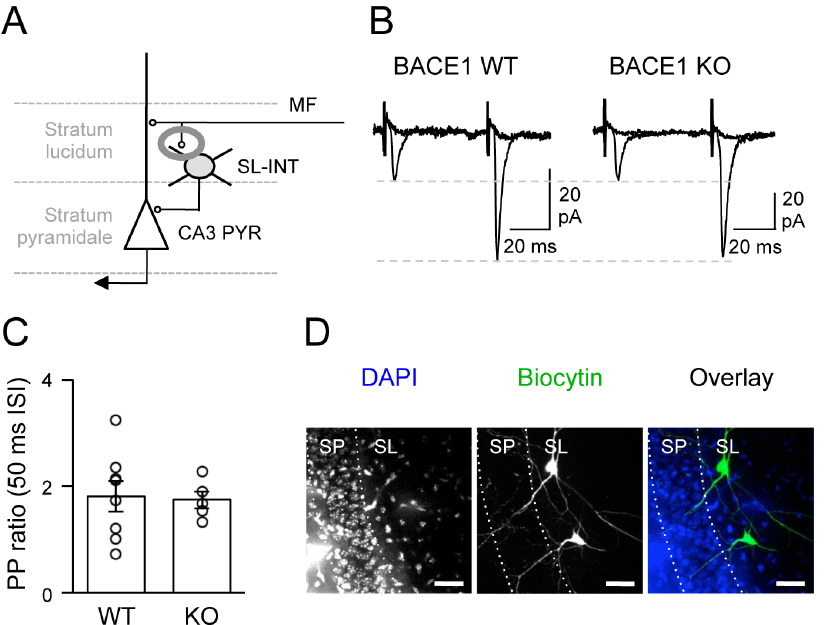
Figure 3. Normal synaptic function of MF inputs onto SL-INTs of BACE1 KOs. (A) A diagram highlighting the synapses of MF terminals onto inhibitory SL-INTs. (B) Representative evoked EPSC traces from SL-INTs following paired-pulse stimulation at 50 msec ISI before and after DCG-IV application in WTs and KOs. (C) Paired-pulse (PP) ratio was not changed between the two genotypes at 50 msec ISI. PP ratio of each cell is shown as open circles. (D) Immunohistochemical labeling of representative biocytin filled SL-INTs of CA3. Left: DAPI staining of the CA3 subfield where biocytin filled interneurons were located. Stratum pyramidale (SP) and stratum lucidum (SL) borders are shown (white dotted lines). Middle: Biocytin staining of two recorded SL-INTs. Right: Overlay of DAPI (blue) and biocytin (green). Scale: 40 m m.